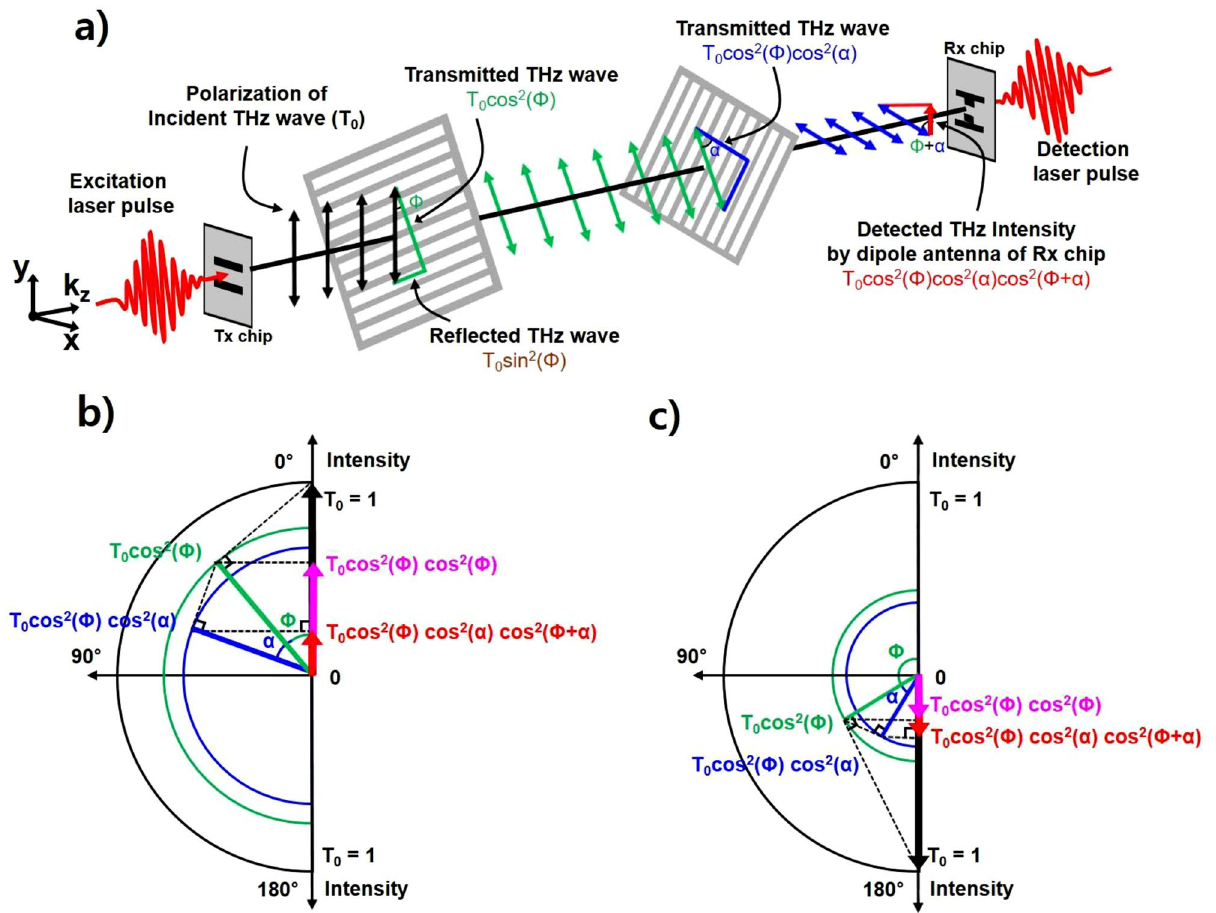
Figure 4. ( a ) Schematic diagram of the polarization change by the two GMR grating films when Φ = 40° and α = 30°. ( b ) The polarization change by the GMR films in a polar coordinate system and the intensity of the THz wave in a Cartesian coordinate system. The green and blue lines indicate the transmitted THz waves after passing through the first and second GMR films, respectively. The arrows indicate the detected THz intensity by the dipole antenna: The polarization range is 0° < Φ < 90°, where Φ = 40° and α = 30°. ( c ) The polarization range is 90° < Φ < 180°, where Φ = 120° and α = 30°.